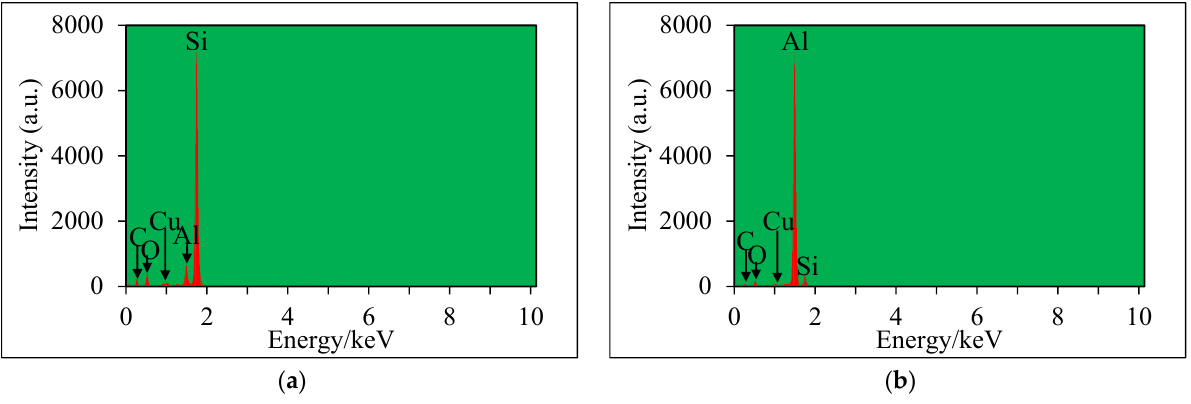
Figure 3. The results of EDS measurement on the machined surface of No.4 in Table 4. ( a ) Region A. ( b ) Region B. Table 5. The element composition on the machined surface of No.4 in Table 4. Region Element